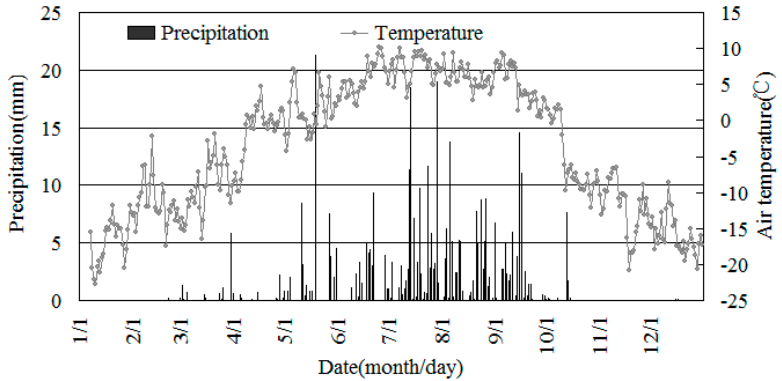
Figure 13. The precipitation and air temperature changes in the study area.